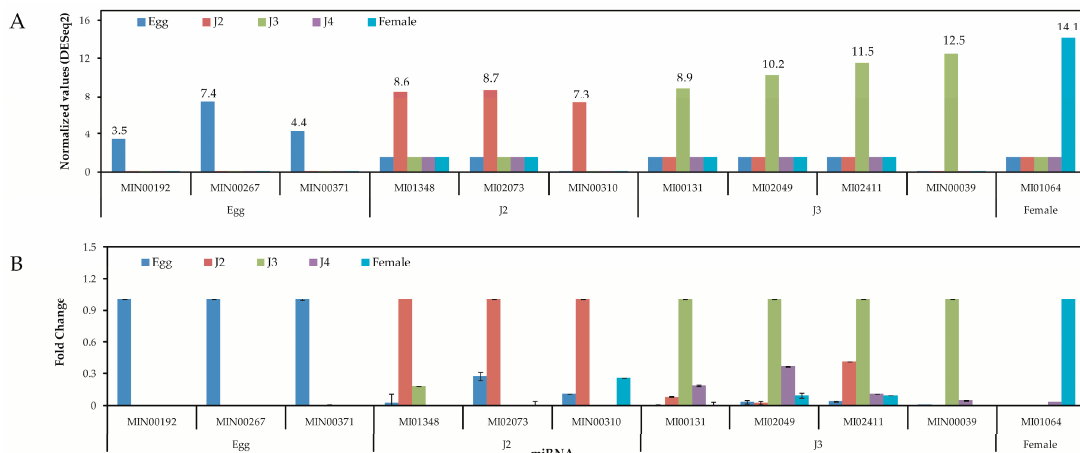
Figure 8. Validation of sequencing and real-time expression of stage-specific miRNAs. ( A ) Expression profiles of selected known and novel stage specific miRNA from high-throughput sequencing data. The normalized values of the stage-specific miRNAs are given at the top of the columns. Columns with DESeq2 values not mentioned had a normalized score of 0.1 to 1.6; ( B ) relative expression levels of known and novel miRNA studied using qPCR. The miRNA MI03018 (miR-58) was used as an internal standard.